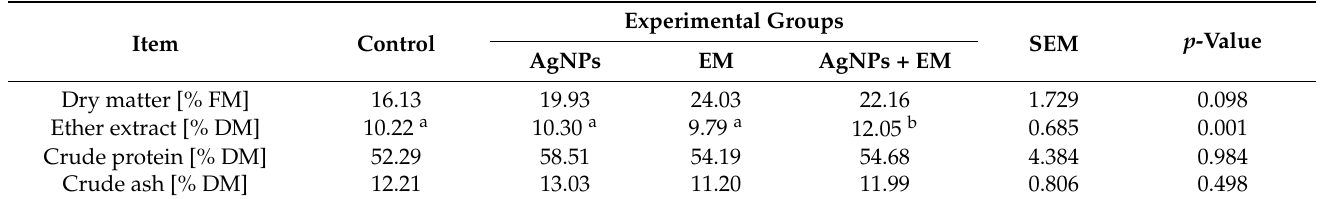
Table 1. Proximate composition of snail carcasses (%) in the control and experimental groups.